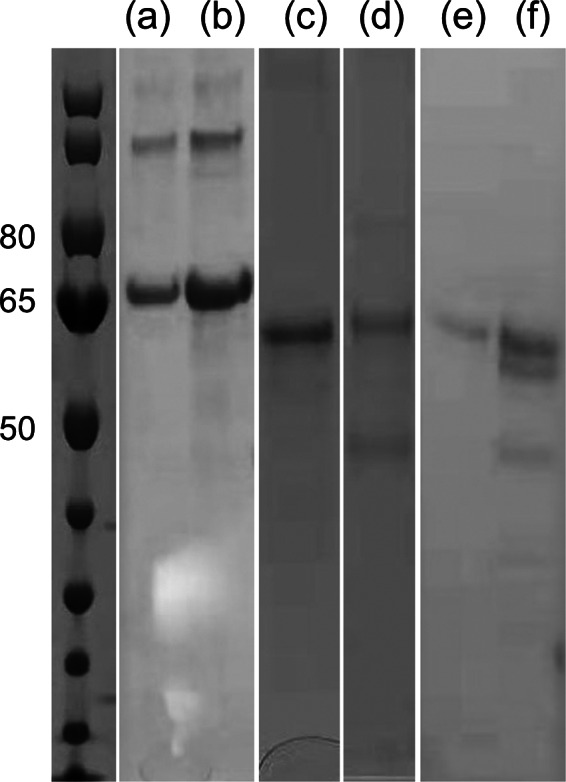
Gel-electrophoresis of purified QTY code designed Fc-fusion receptors. (a) CXCR2QTY–Fc; (b) CCR9QTY–Fc; (c) IL4RαQTY–Fc; (d) IL10RαQTY–Fc; (e) IFNγR1QTY–Fc and (f) IFNλR1QTY–Fc. The molecular weight of the ladder is labelled on the left in KDa. It is plausible that these bands can be attributed to dimeric or higher order of multimeric receptors. For panels d and f, the bands are likely to be impurities that are too close to the target band which we were not able to separate with either His-tag or gel-filtration purification. These bands might be eliminated with further Protein A/G purification in future experiments